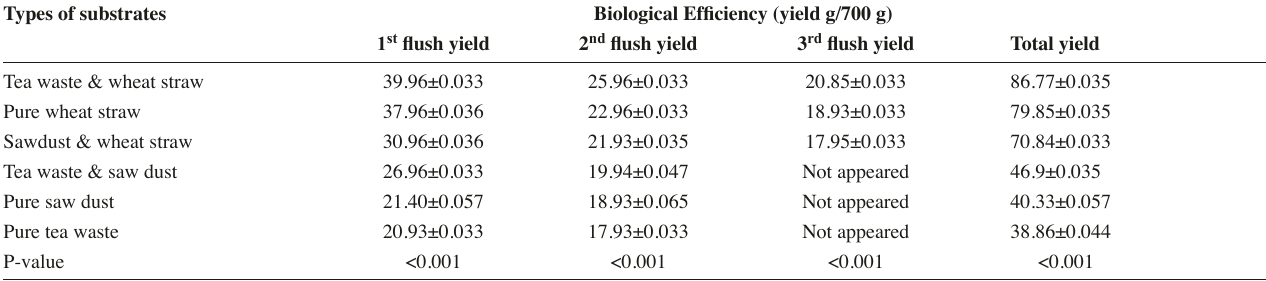
Tab. 4: Yield (g/700 g) obtained from different types of substrates at 30 ℃ Types of